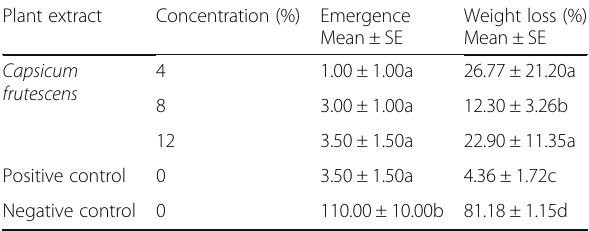
Table 3 Pesticidal effect of ethanolic extract of C. frutescens on emergence and weight